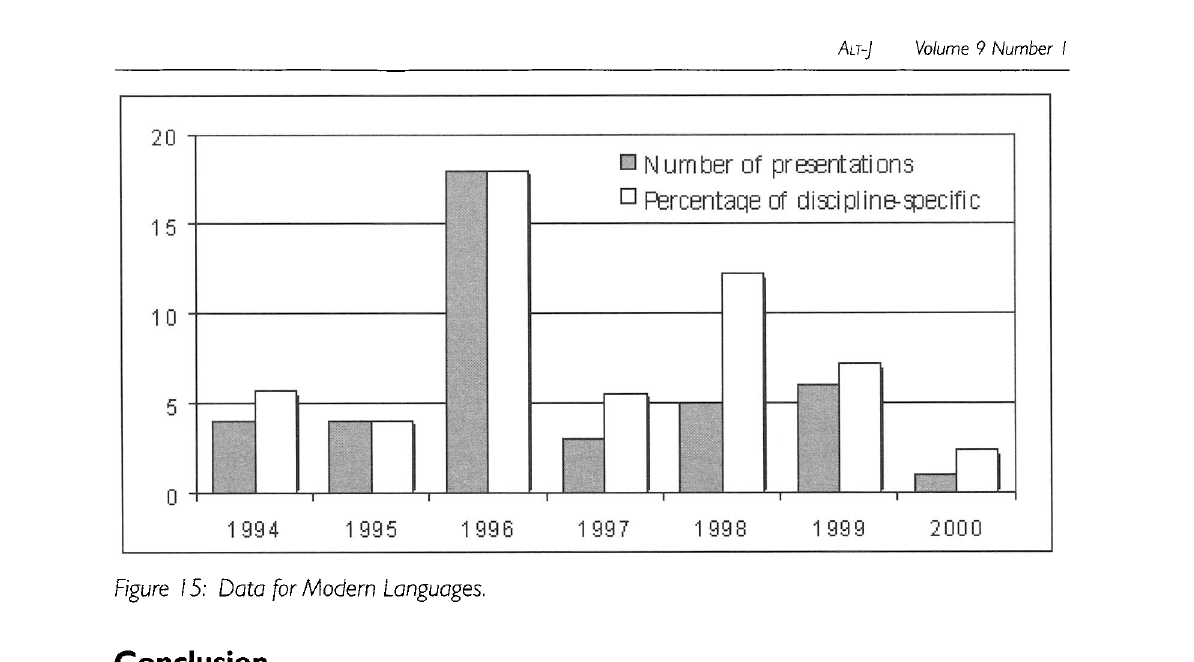
Figure 15: Data for Modem